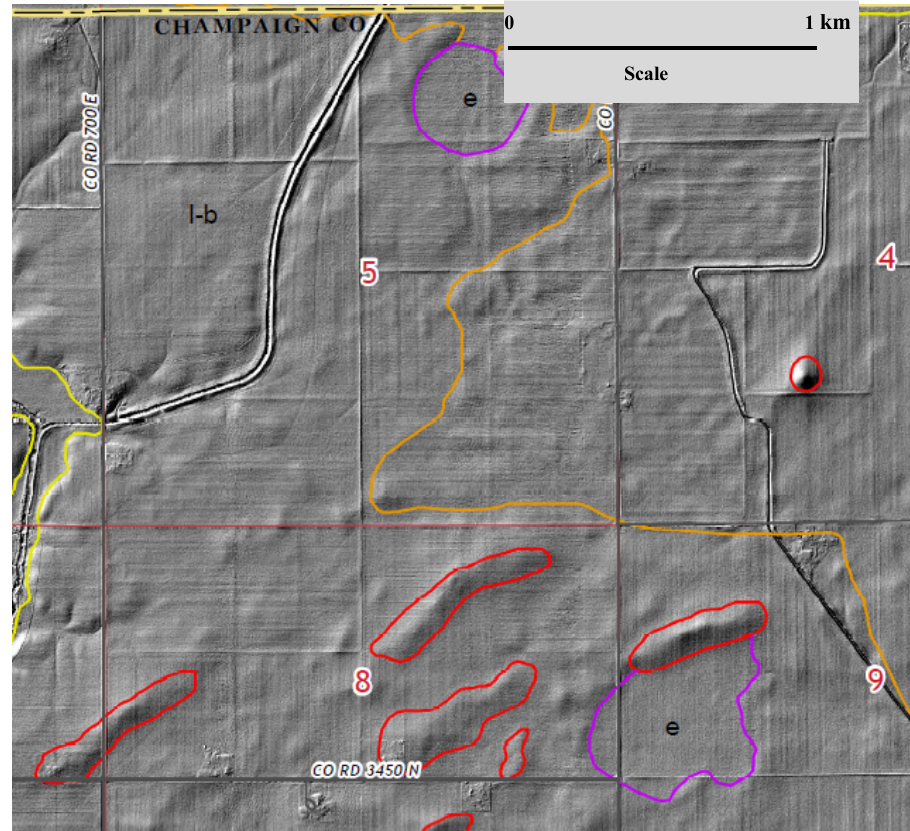
Figure 5. LiDAR hillshaded DEM outlined in Figure 4 resembling the following geomorphologic features within the Gibson City East Quadrangle: glacial lake plains outlined in purple, outwash plain outlined in brown, and esker-type ridges / kame-like features outlined in red. The red numbers indicate the section number.